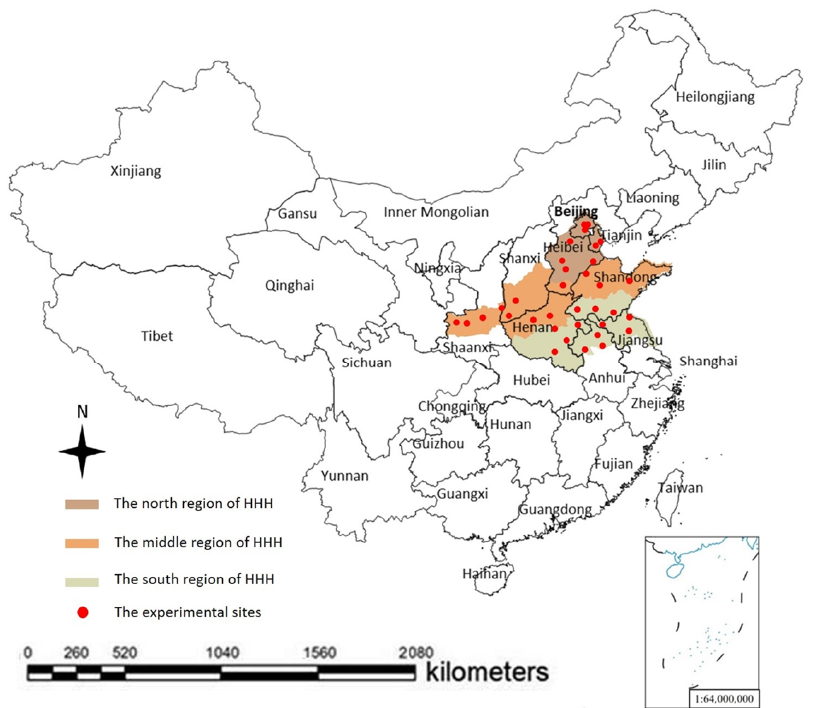
Figure 1. The spatial distribution of the experimental sites and soybean fields in Huang-Huai-Hai region, China.